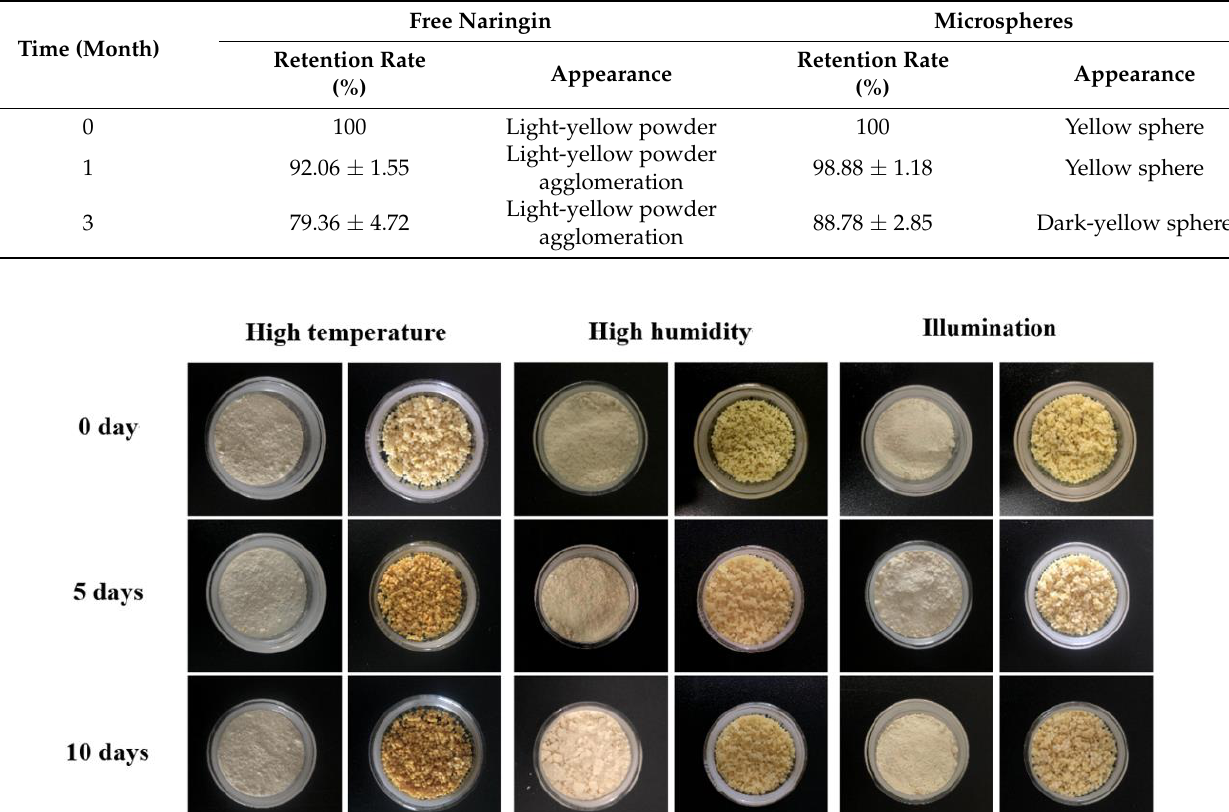
Figure 8. The whey precipitation of yogurt (A: CY, B: NY, C: MY). In storage, the acidity of yogurt would increase gradually due to microbial acid pro- duction, but high acidity would produce a stimulating taste and inhibit beneficial bacteria that do not tolerate acid in the intestine. As shown in Table 4, the pH of yogurt decreased during the storage, and there was no significant difference between the pH of NY and CY on days 7 and 14. The pH value of the microspheres was always higher than that of the